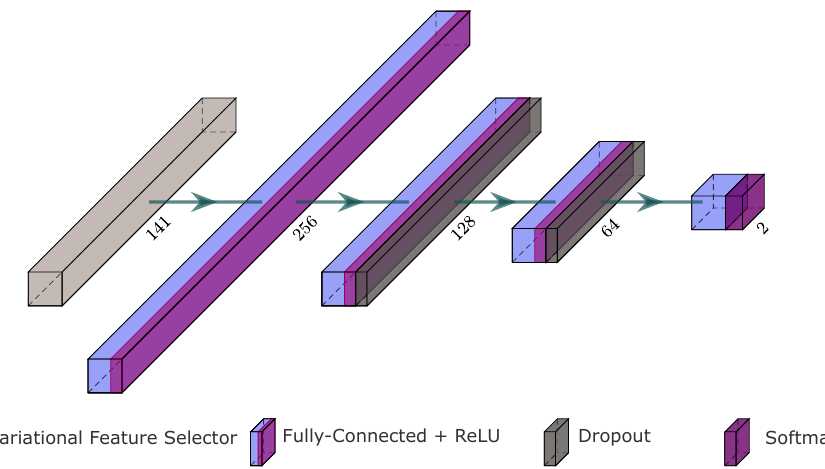
Figure 3. Deep learning architecture used for the feature selection based on variational dropout approaches. The first layer corresponds to variational dropout as a feature selector, illustrated in Figure